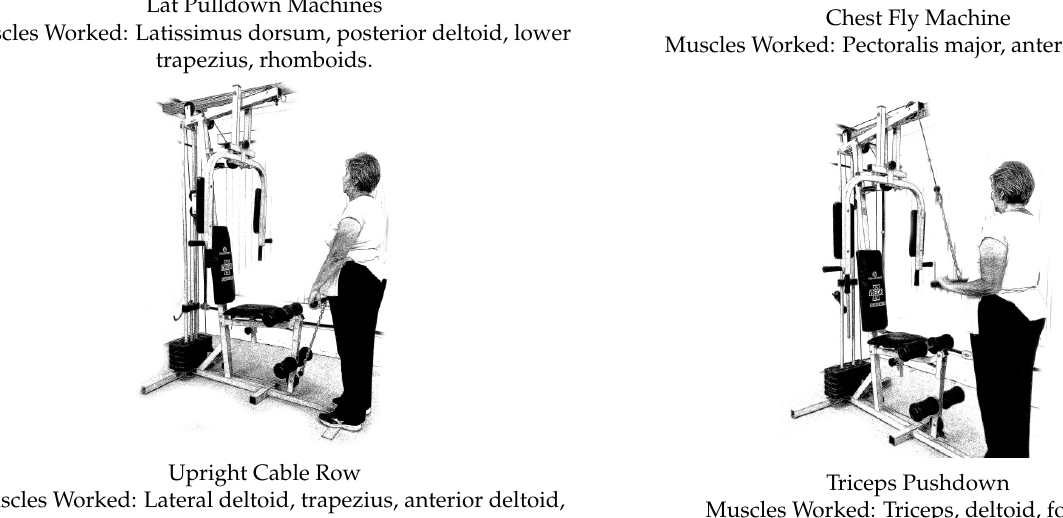
deltoid, supraspinatus, infraspinatus, minor round.